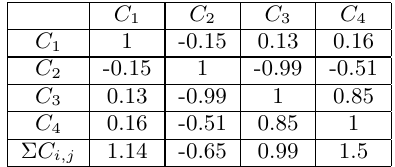
Figure 4: PCG segmentation to detect systolic and diastolic area; a) Raw signal, b) Complex Gaussian Wavelet coefficients. Table 1: The average coefficients of correlation be- tween